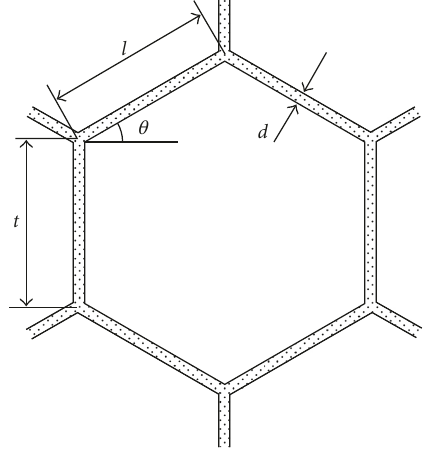
Figure 2: The unit cell of general hexagonal core